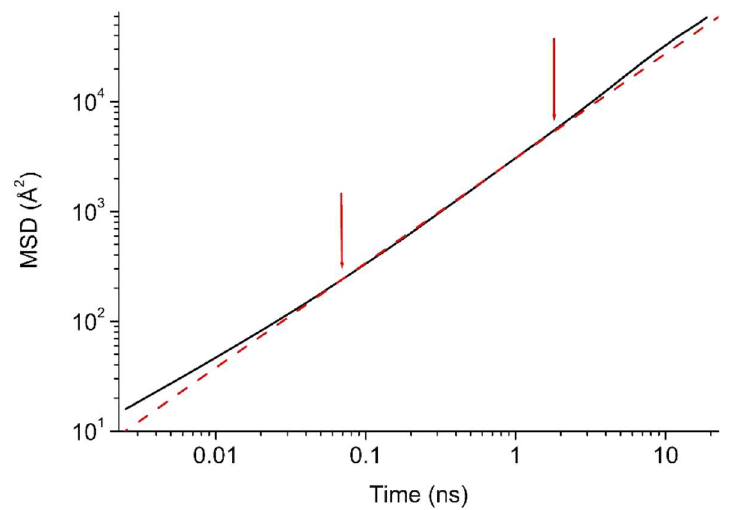
Figure 20. Black: example of MSD vs. time for gas diffusion in a molten polymer. Red: the dashed line with slope = 1 and the two arrows mark the region of Fickian diffusion.